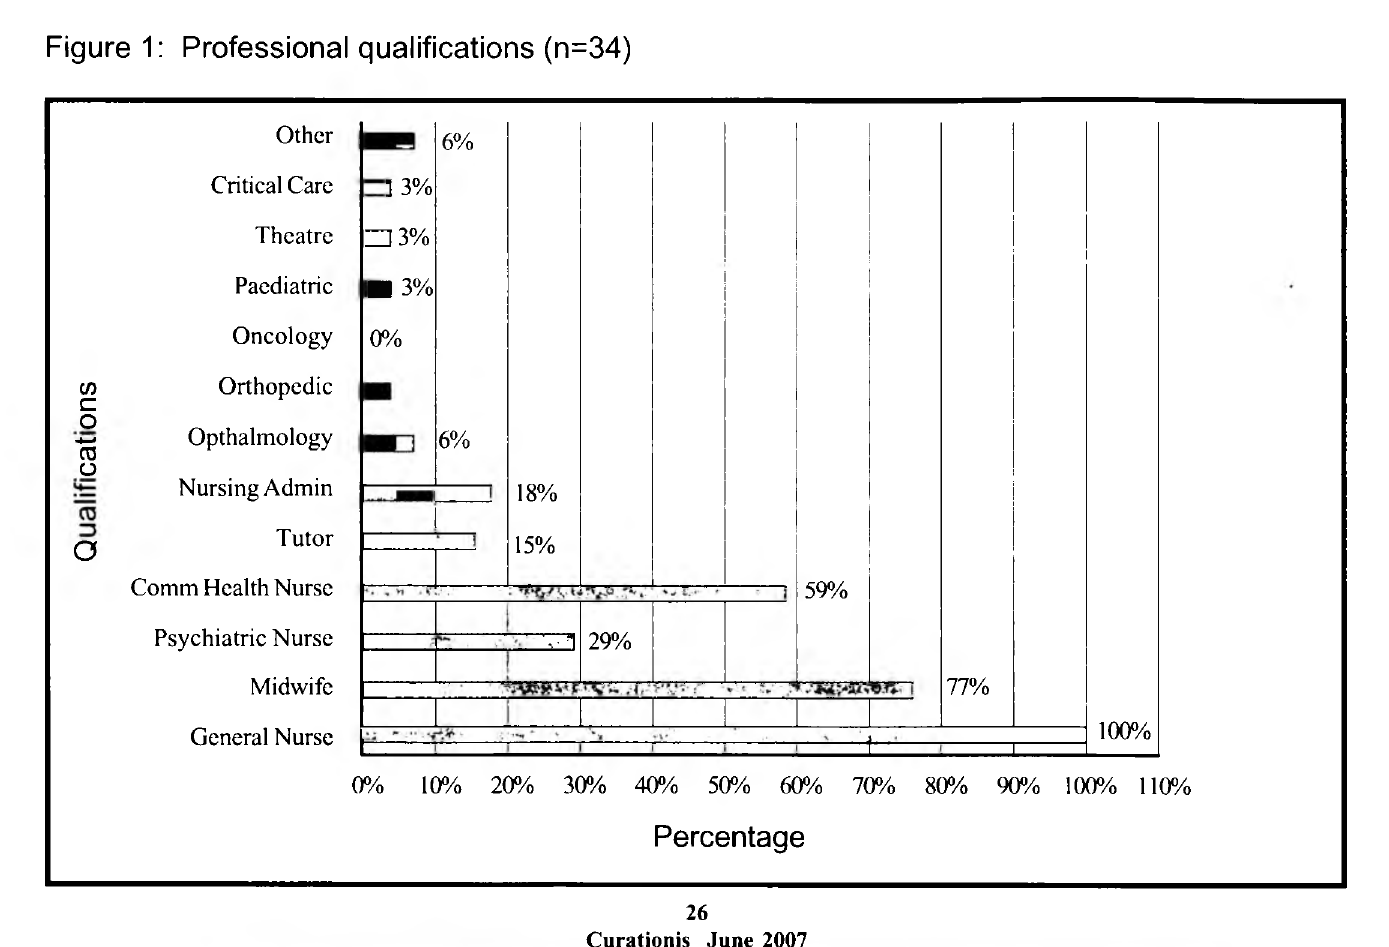
Figure 1: Professional qualifications (n=34)